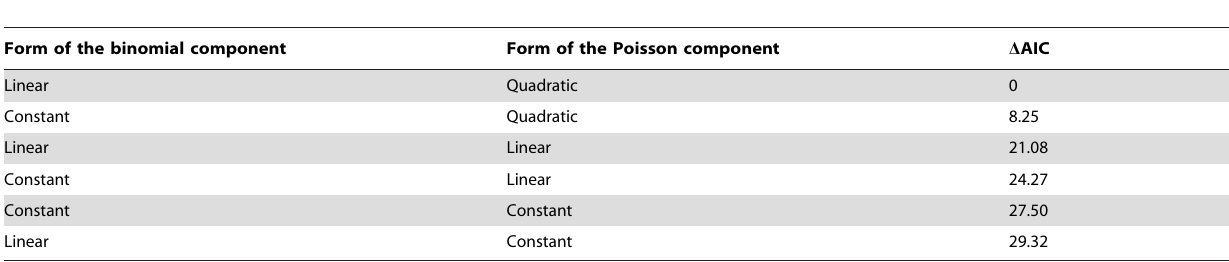
Table 3. The candidate set of zero-inflated Poisson regression models of the relationship of true counts with reported counts of reared